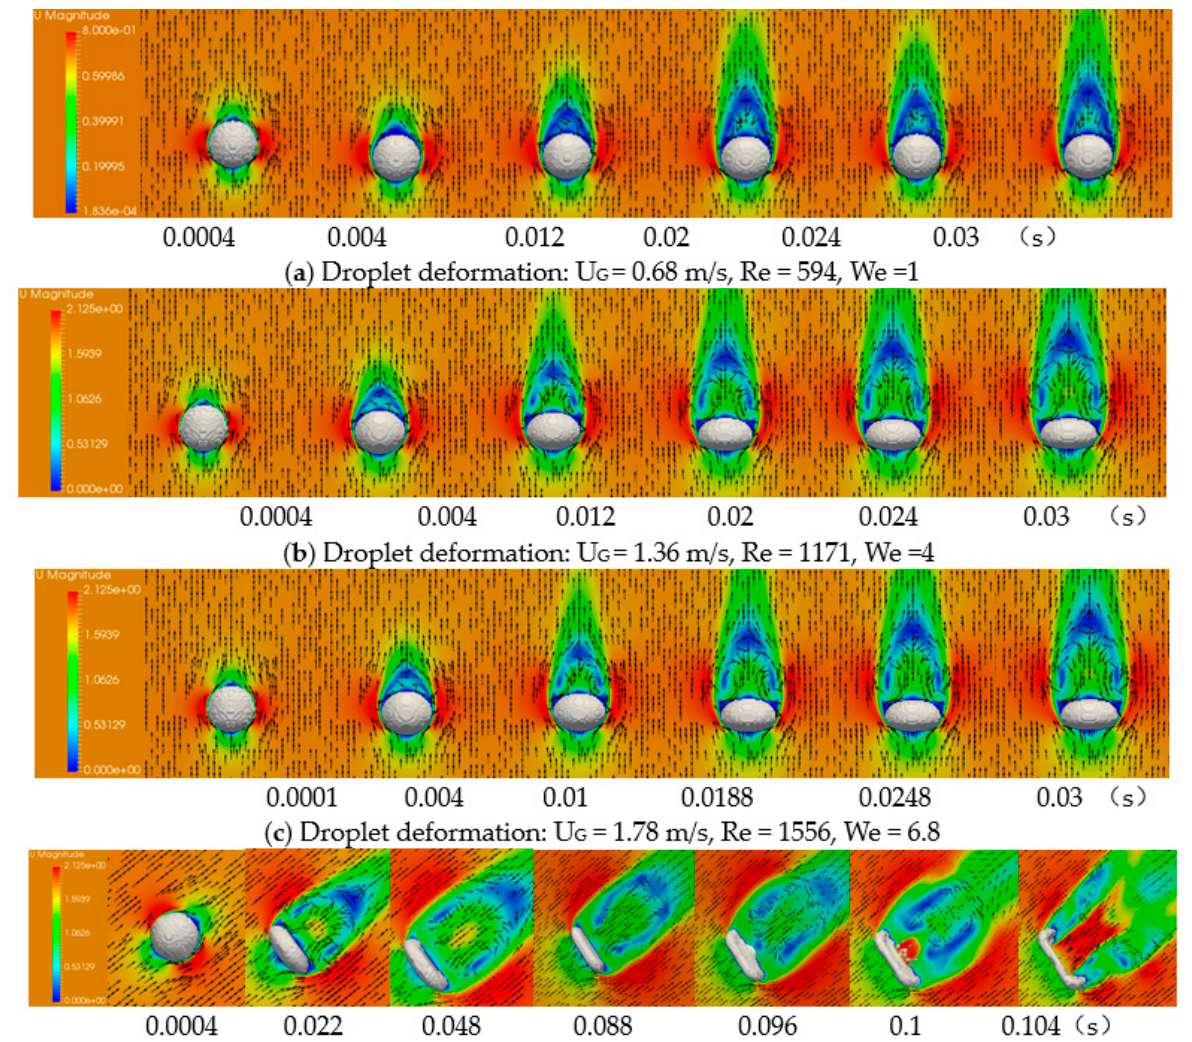
Figure 4. The shape characteristics of a single droplet under different Weber numbers.